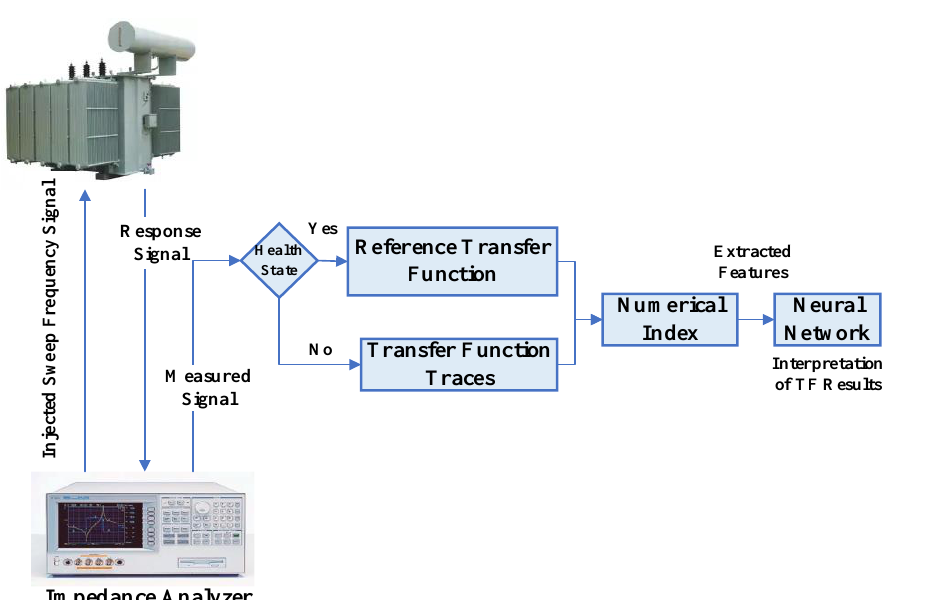
Figure 3. Structure of fault diagnosis and TF test results ’ interpretation procedure.